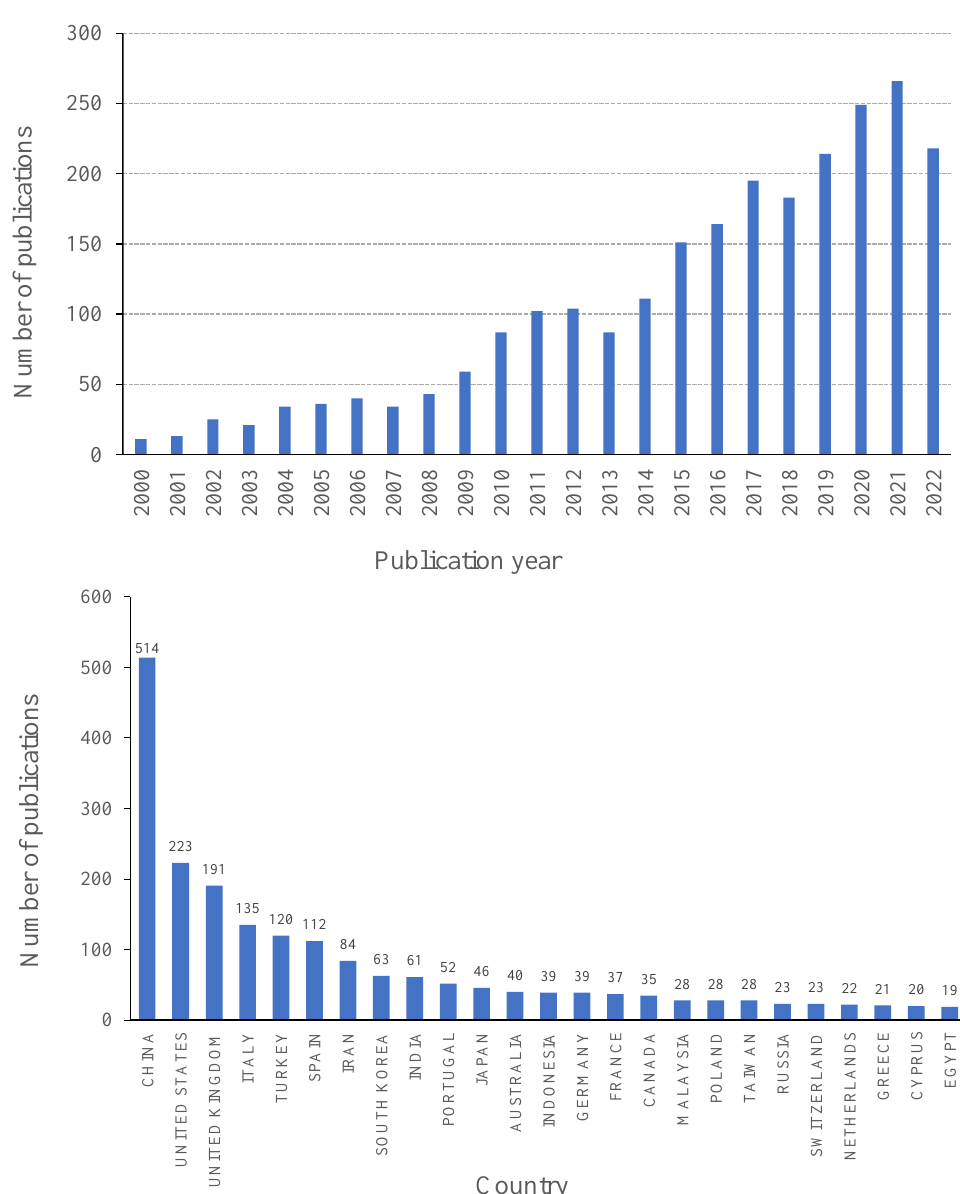
Figure 3. Publications on vernacular architecture indexed in the Web of Science for the investigated period. Above: distribution over time; Below: top 25 countries with the most published documents (data collected from the Web of Science in July 2022).